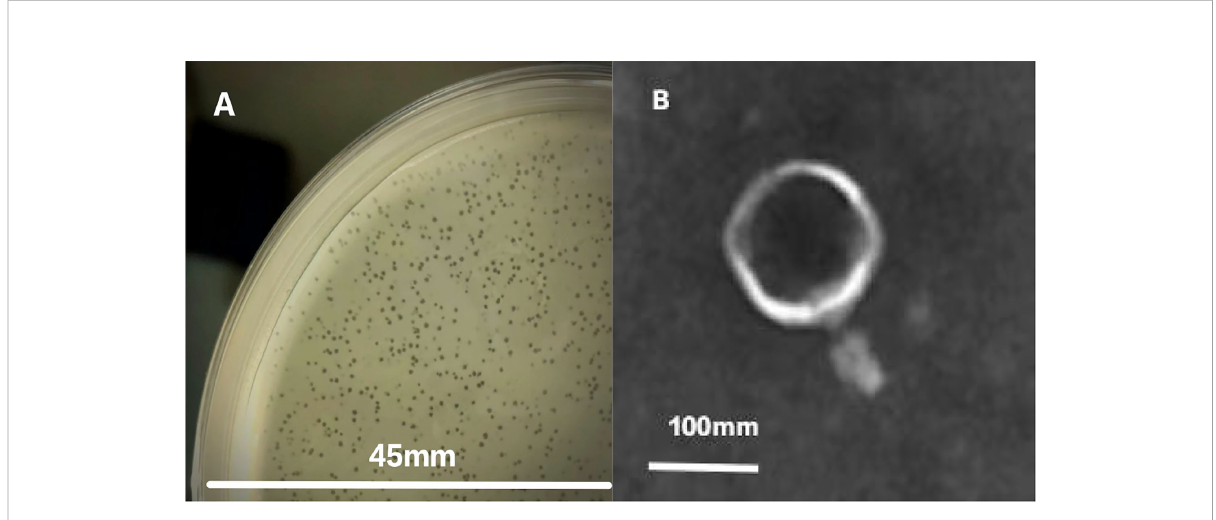
FIGURE 1 Plaque appearance (A) and virion morphology (B) of phage